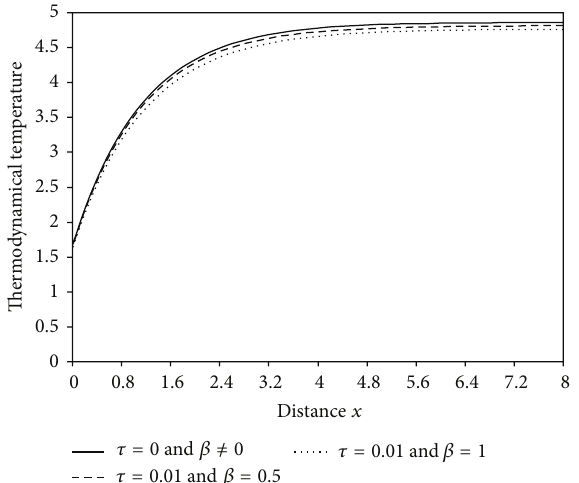
Figure 5: Dependence of displacement distribution on velocity V of heat source.